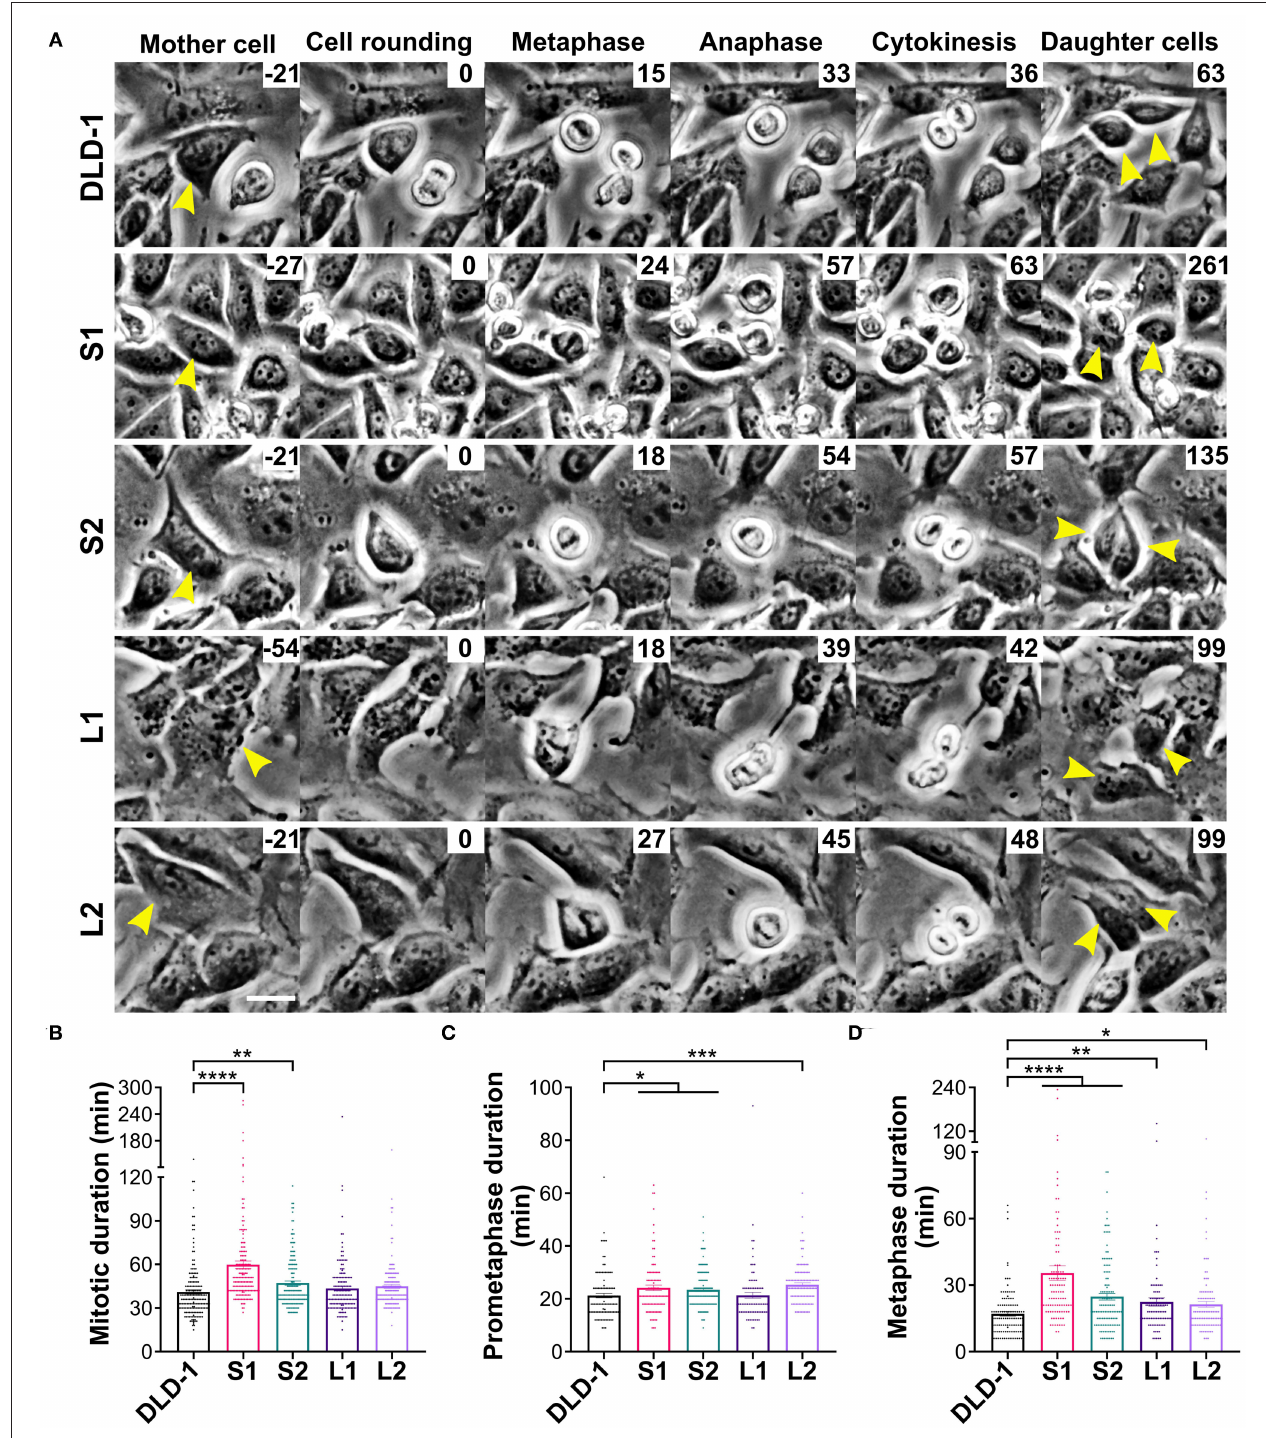
FIGURE 3 | Small 4N DLD-1 cells spend more time in mitosis due to a delay in metaphase. (A) Examples of parental DLD-1 cells and cells from 4N DLD-1 clones S1, S2, L1, and L2 (top-to-bottom) progressing through mitosis. Elapsed time is shown in minutes (top-right corner), with 0min corresponding to cell rounding. Yellow arrowheads point to the dividing cell (Mother cell column) and to the two daughter cells (right column). Scale bar, 25 µ m. Quantification of (B) mitotic duration ( n = 179, 167, 161, 161, and 150 cells, respectively), (C) prometaphase duration ( n 111, 101, 118, 90, and 110 cells, respectively), and (D) metaphase duration ( n = = 111, 101, 121, 91, and 101 cells, respectively). * p < 0.05, ** p < 0.01, *** p < 0.001, and **** p < 0.0001, when compared to the parental DLD-1 cells by Student’s t -test. Graphs in panels (B–D) represent data collected from three independent experiments reported as mean SEM with individual data points. ±